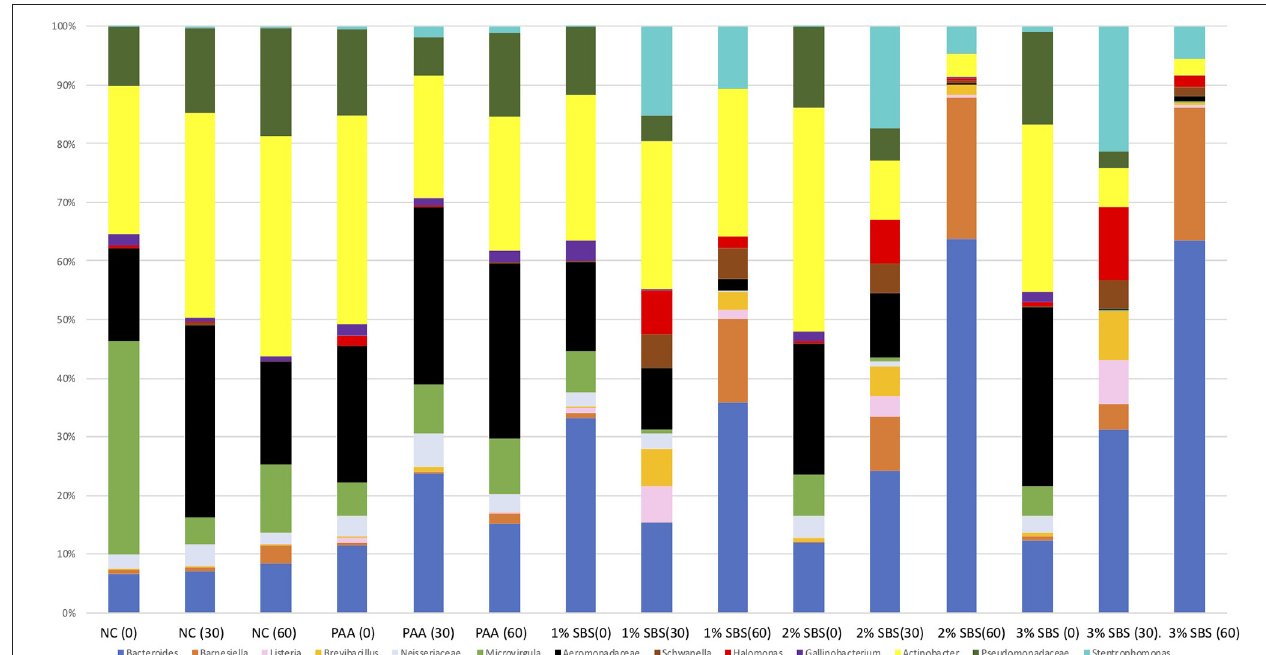
FIGURE 5 | The Analysis of Composition of Microbiomes (ANCOM) throughout sanitation. Relative stack bar plots were created from the top 11 OTUs with a Q < 0.05 and a significant leverage effect that were statistically associated with the time by treatment effect. Ultimately, significant variations in microbial composition occur over time and by